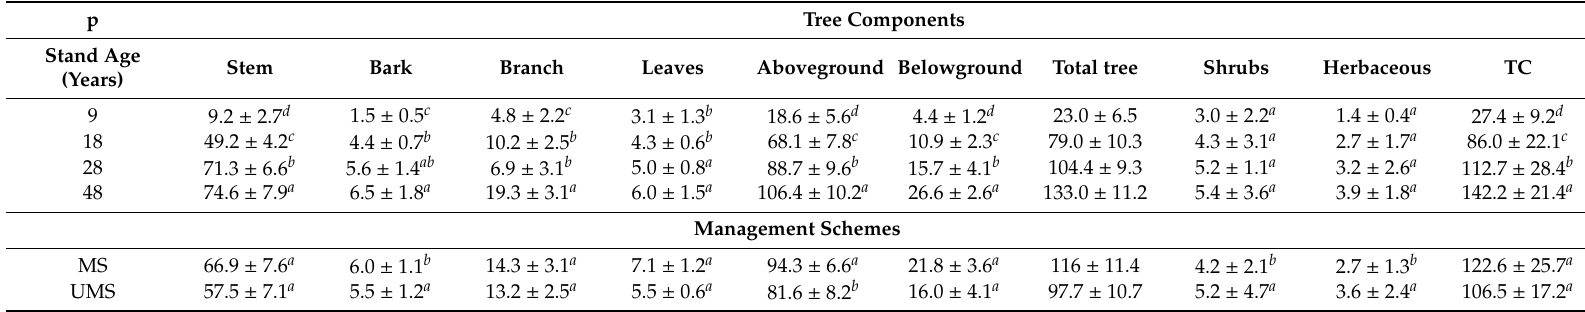
Table 2. Biomass carbon (Mg ha − 1 ) in trees and forest floor vegetation in the 9, 18, 28, and 48 year age groups and the two management treatments of Masson pine ( P. massoniana ) in the studied area. (TC = Total Carbon). Di ff erent lower-case letters within columns indicate the significance level among di ff erent variables.